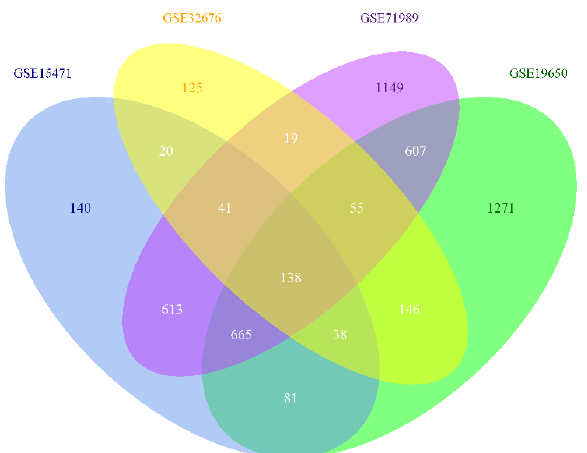
Figure 1. Four-set Venn diagram showing the common differentially expressed genes from the four Gene Expression Omnibus series datasets. Differentially expressed genes (DEG) were identified with classical t test, statistically significant DEG were defined with p < 0.01 and log 2 -fold change (log 2 FC) >1 or < −1 as the cut-off criterion for every dataset.